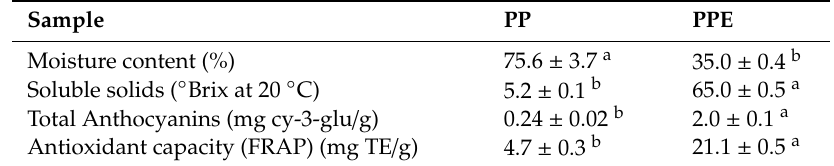
Table 1. Physico-chemical characterization of Purple flesh potato and its extract (PPE).